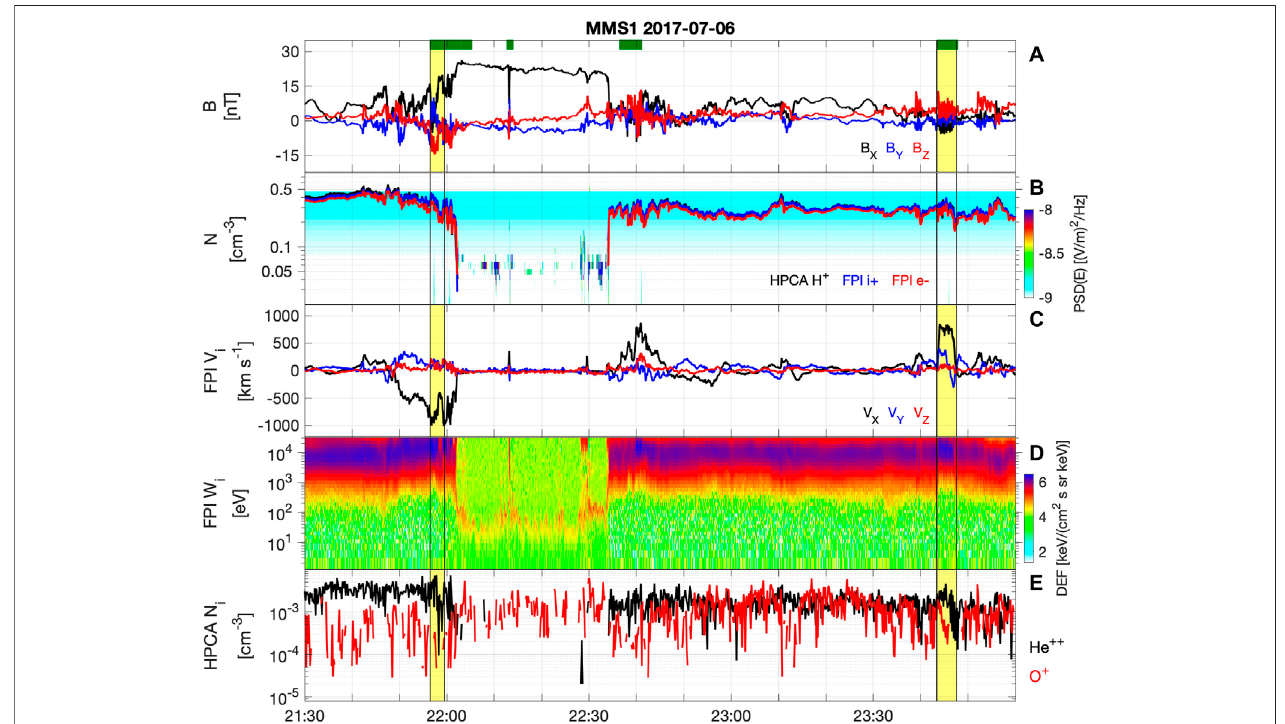
FIGURE 1 | MMS observation of the Earth ’ s magnetotail on July 06, 2017. MMS1 data of (A) magnetic fi eld B , (B) number densities of hydrogen (H + , black) from HPCA, all ions (blue) and electrons (red) from FPI and electron number density derived from the Langmuir waves observed by EDP, (C) ion bulk velocity V i from FPI, (D) FPIionomnidirectionaldifferentialenergy fl ux, (E) numberdensitiesofHe ++ (black)andO + (red)ionsfromHPCA.AllvectorsarepresentedinGSEcoordinates,whichare close to Geocentric Solar Magnetospheric (GSM) coordinates in this event. The horizontal green bars in the top of (A) denote the burst-mode time intervals, and detailed analysis of the ion VDFs in the two yellow-shaded intervals are presented in the following fi gures.